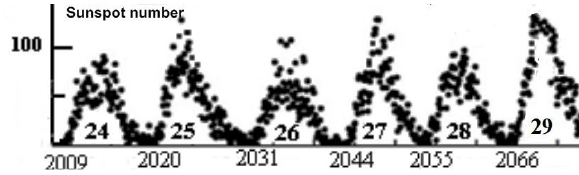
Figure 14. Forecast of low solar activity. 25-28 SA cycles (Ishkov